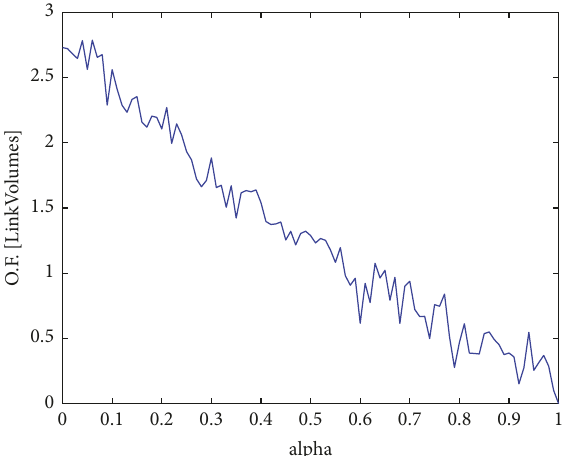
Figure 9: OF1 scan for DNL + fixed UE paths (Set V).